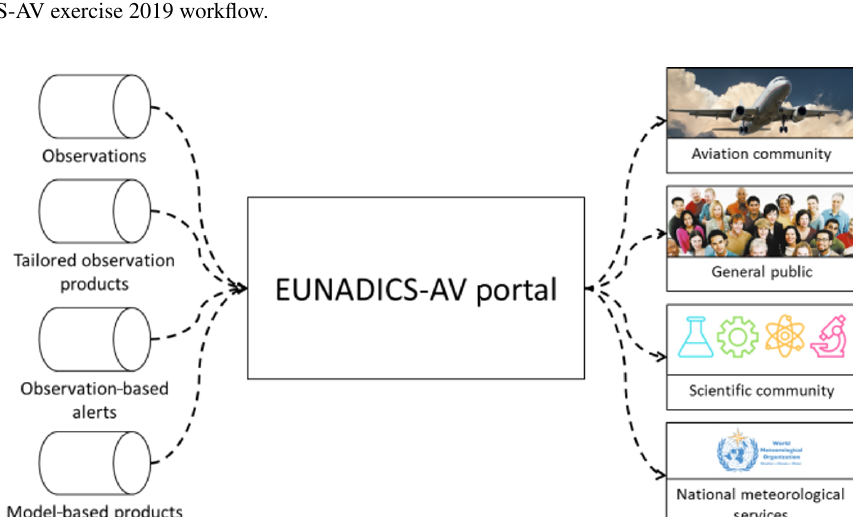
Figure 3. EUNADICS-AV exercise 2019 workflow.